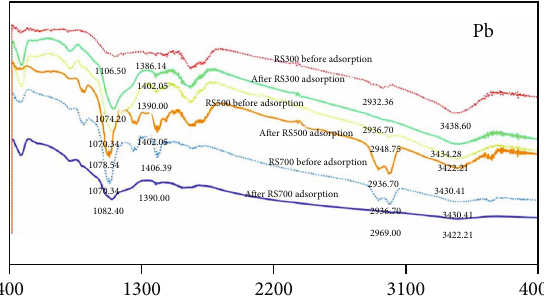
Figure 15: Competitive adsorption mechanism of Pb 2+ in acid solution of straw.